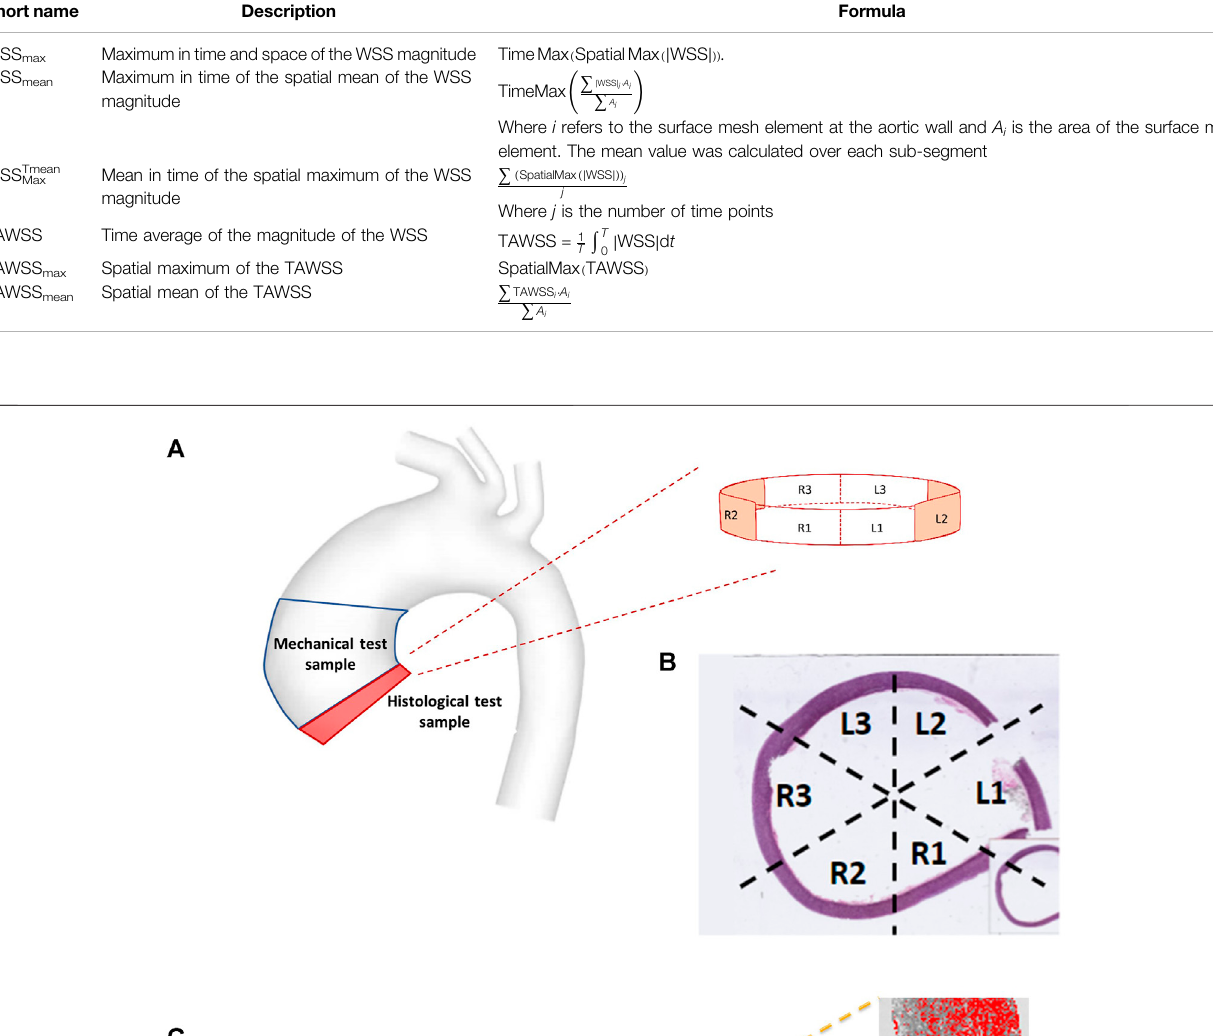
Frontiers in Bioengineering and Biotechnology |